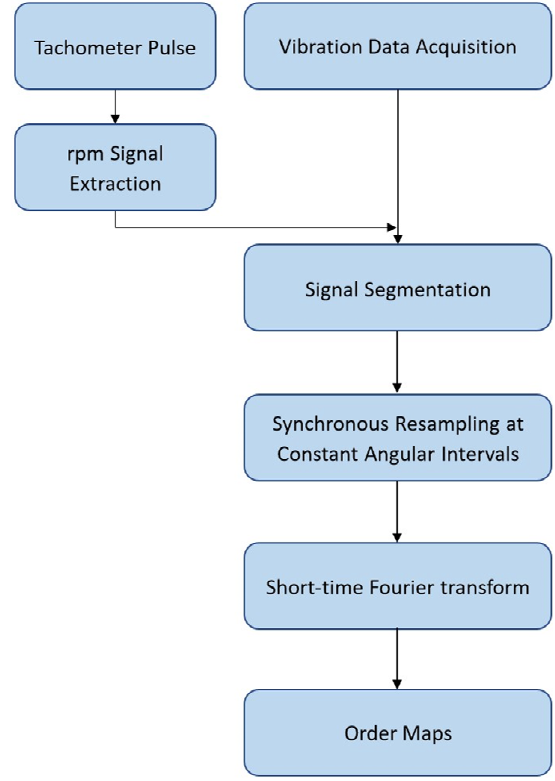
Figure 2. Order maps’ computation procedure.